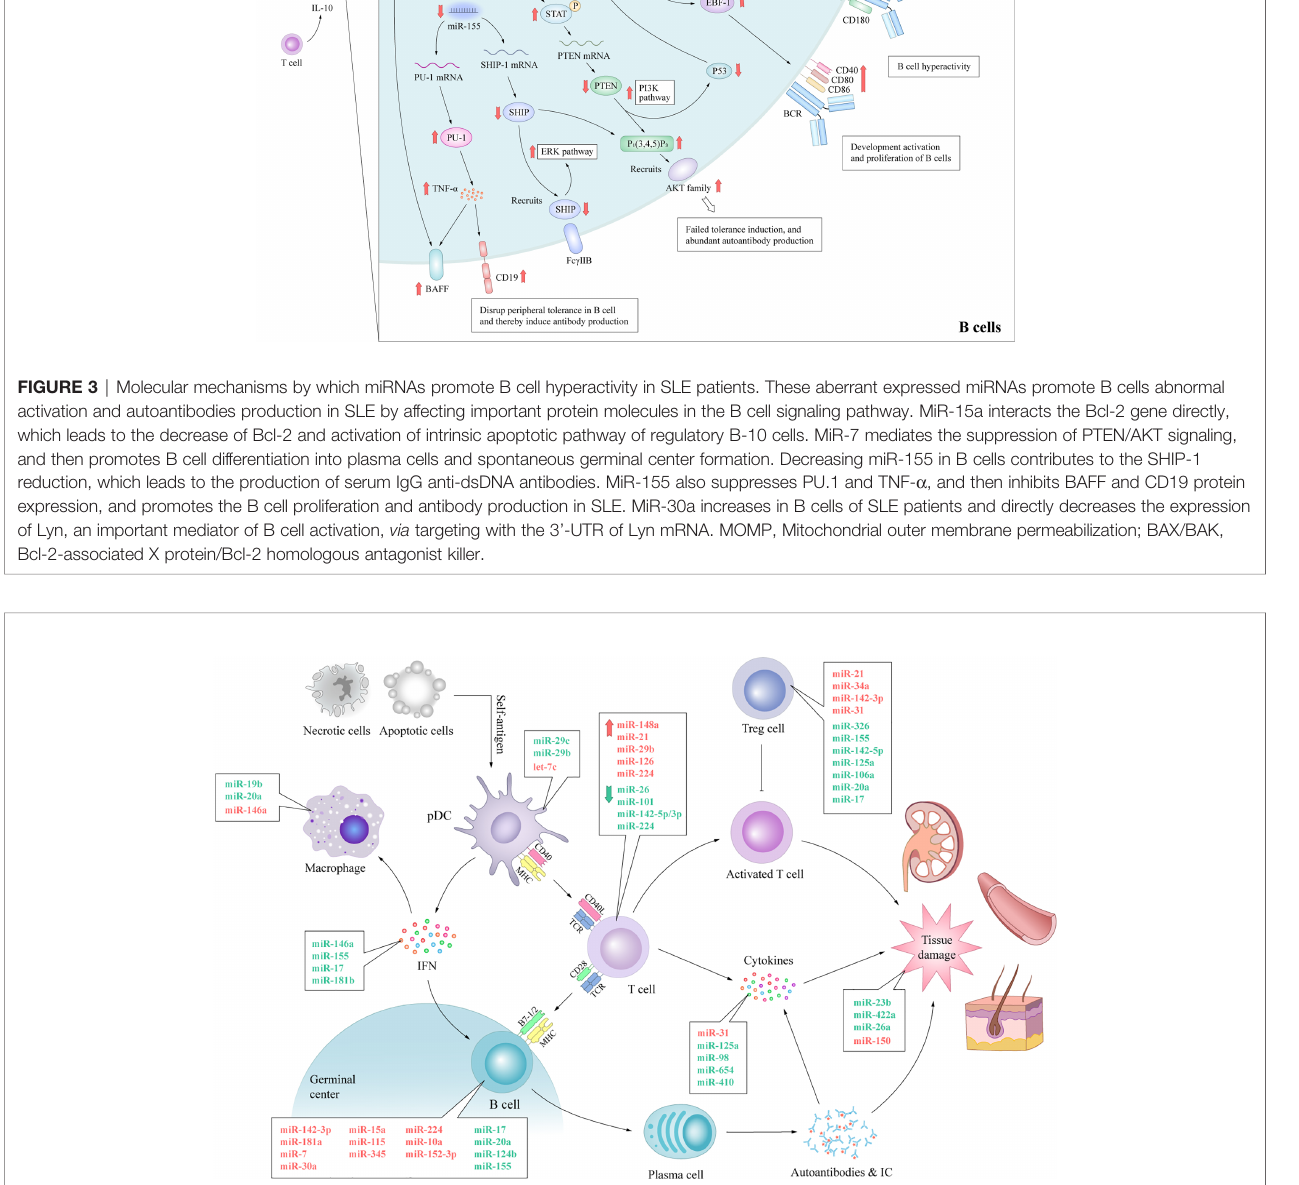
FIGURE 4 | The expression of miRNAs and their involvement in immunological dysfunction of SLE. The aberrant expression of miRNAs can be noticed in almost every vital process of SLE. The expression levels of anti-in fl ammatory miRNAs, such as miR-19b, miR-146a, miR-142-5p, miR-124b and miR-422a, decrease, while the expression levels of pro-in fl ammatory miRNAs, such as miR-146a, miR-224, miR-29b, miR-31 and miR-150, increase. Dysregulated miRNAs disturb the normal biological procedure of immune response by swaying the expression of pivotal protein molecule (e.g. CD40, CD40L, IFN, BAFF) directly or indirectly. These processes lead to autoimmune and tissue damage with aberrantly activated T lymphocytes, over-activated B cells, autoantibody accumulation and abnormally increased in fl ammatory cytokines in SLE. IC, immune complex; TCR, T cell receptor.